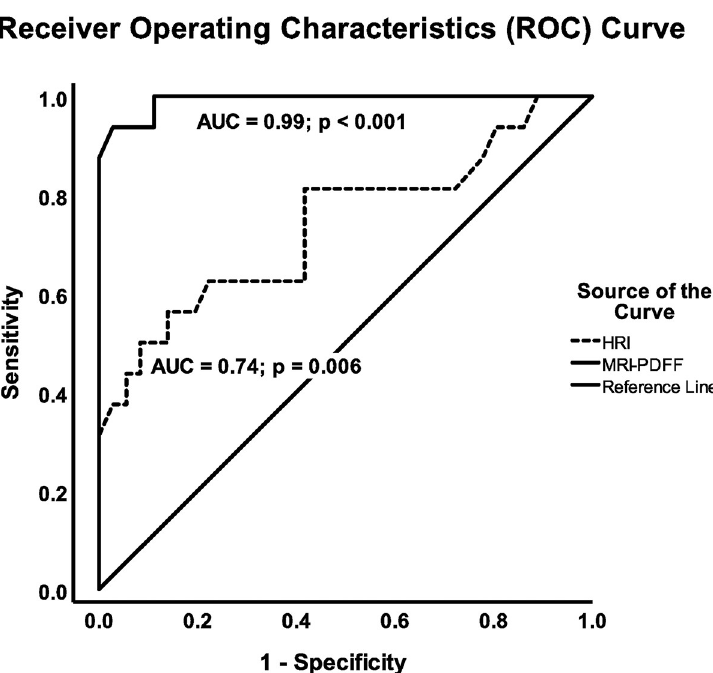
Fig 6. ROC curve using the reference of 5.56% as cut-off point in defining diagnostic performance.